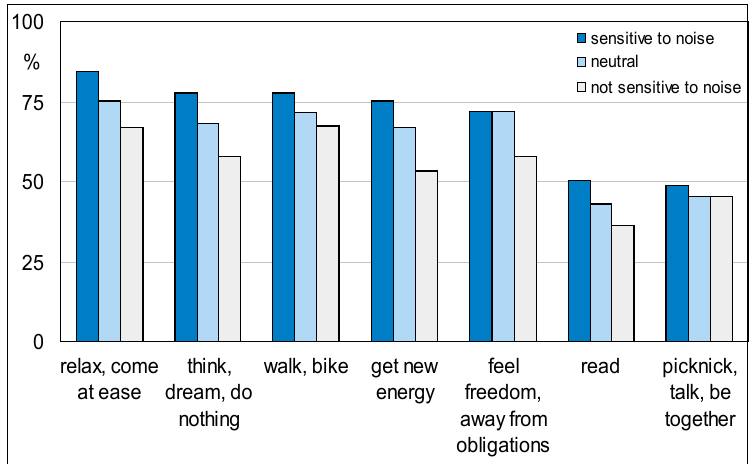
Figure 8. Importance of a quiet area with respect to desired activities.